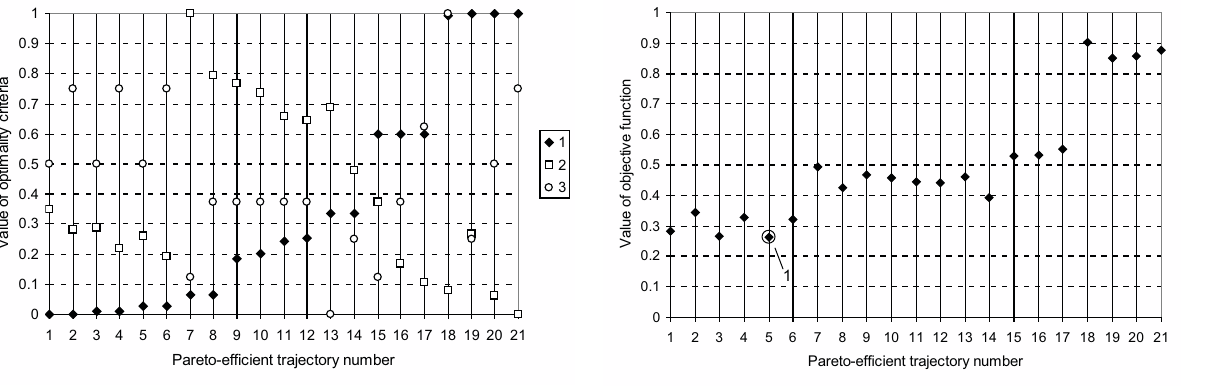
Fig. 2. Optimality criteria values: 1– regularity criterion c 1 ; 2 – efficiency criterion c 2 ; 3 – criterion of maneuvering complexity c 3 Table 2. Parameters of the conflict-free optimal flight trajectory Parameters Values Pareto-effective trajectory № 5 Minimum distance between two aircraft d min , m